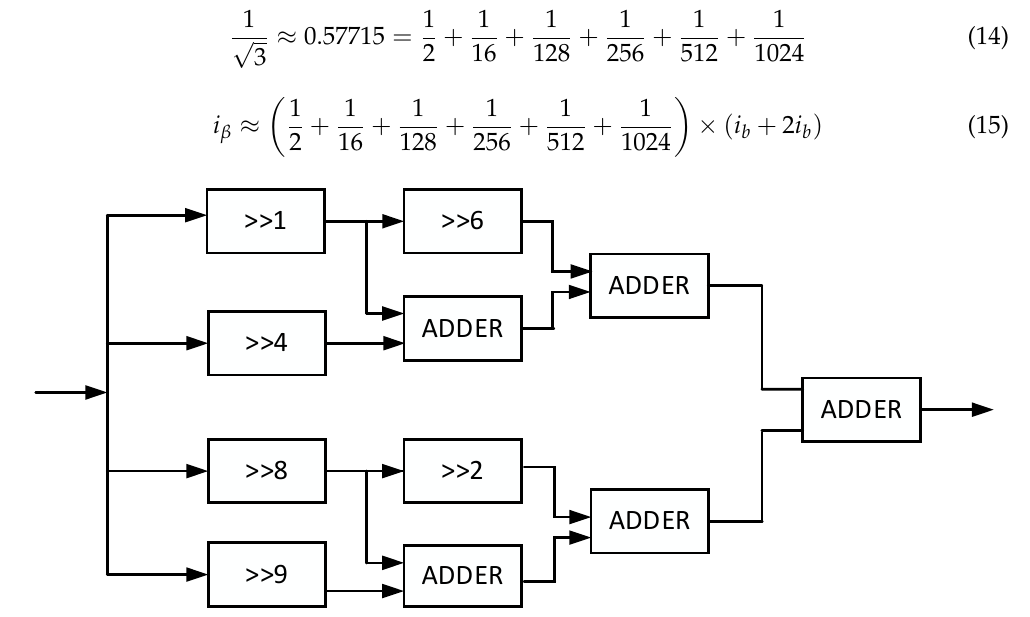
Figure 7. Circuit structure of the second method.